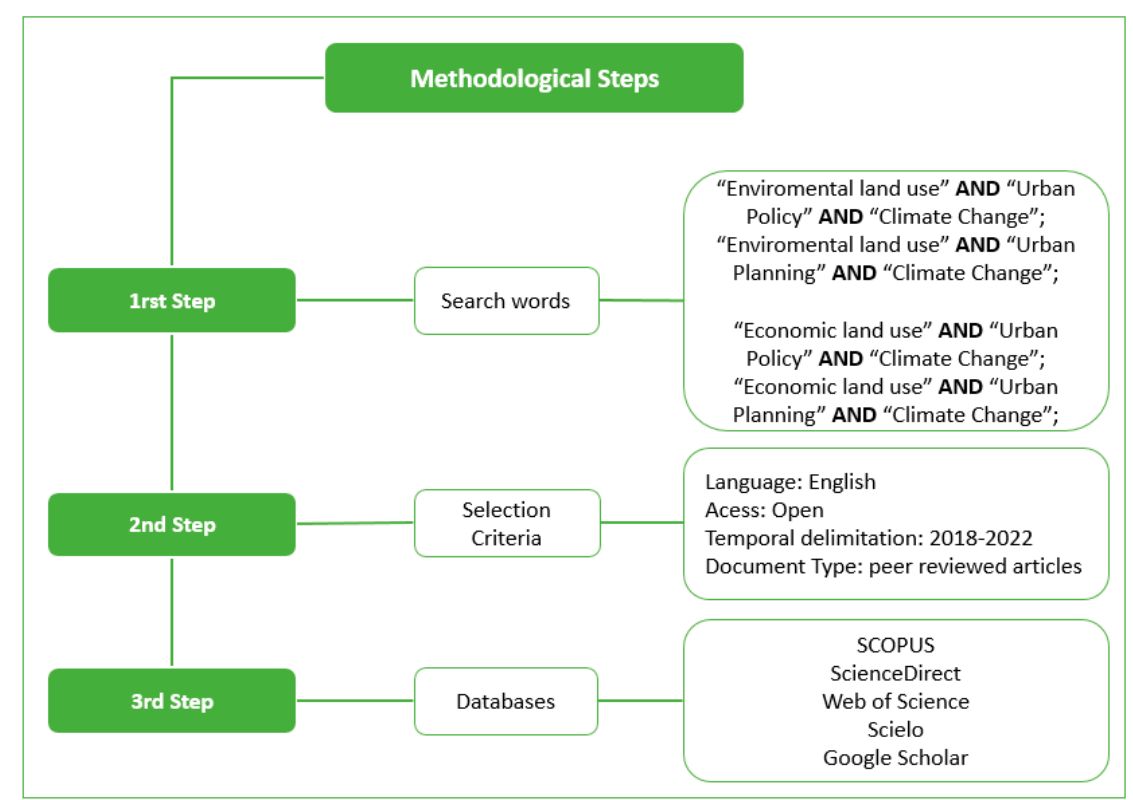
Figure 2. Systematic search